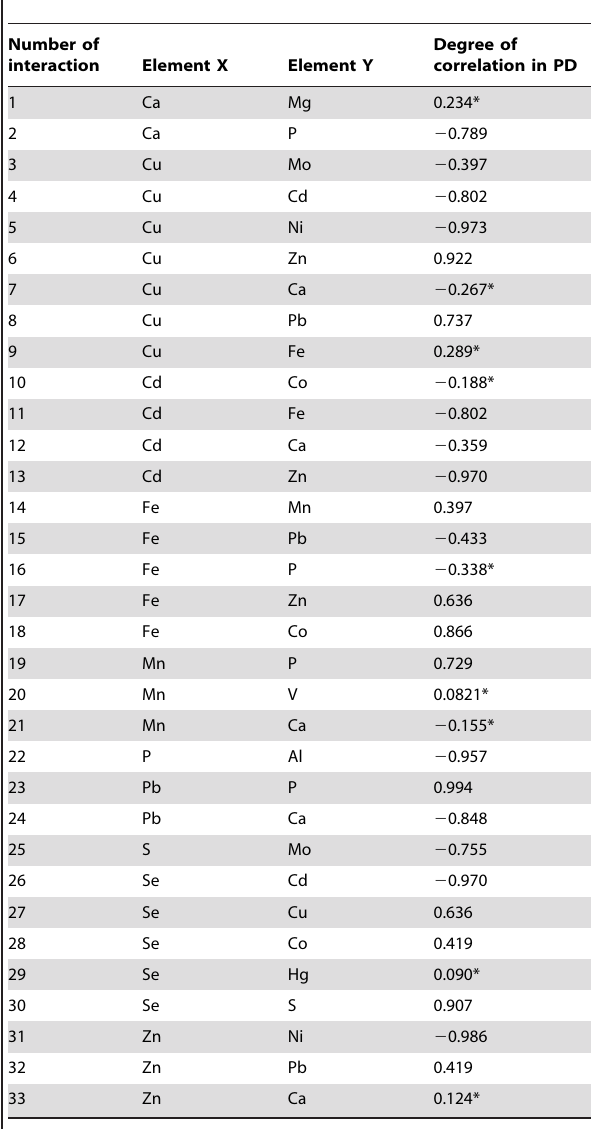
Table 3. Element inter-relationship in PD for element linkage